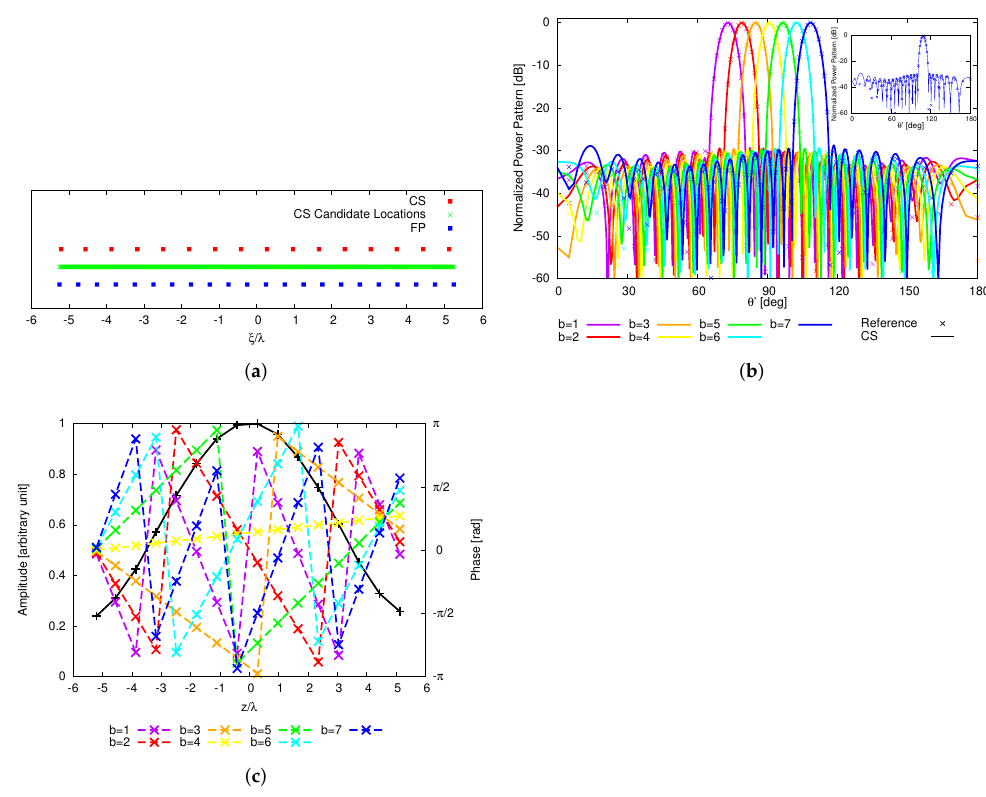
, B = 7)—Plot of ( a ) the MT-BCS synthesized 2